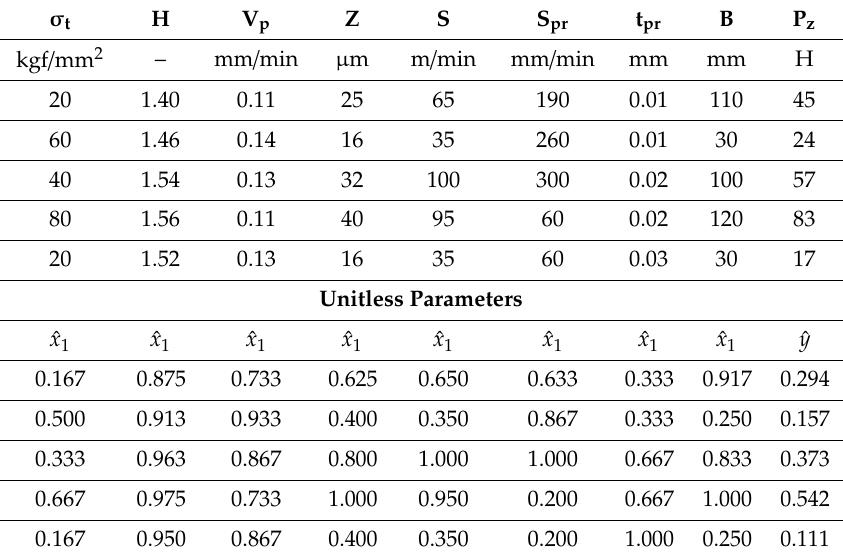
Table 2. Part of the experimental data